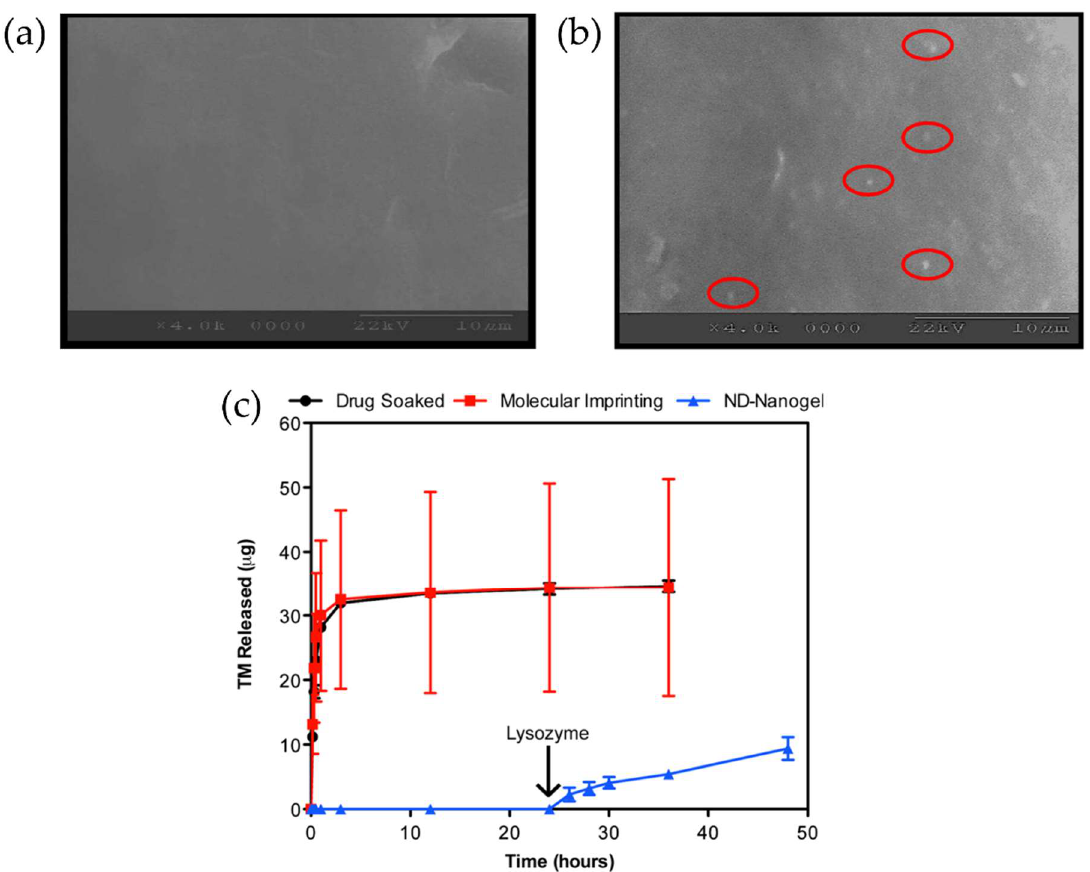
Figure 7 . SEM images of ( a ) the surface of pure poly-HEMA contact lens; ( b ) the surface of nanoparticle-laden poly-HEMA contact lens with visible nanoparticles (red circle). Reprinted with permission from [30]; ( c ) Timolol-eluting profiles from drug-soaked (black line), molecularly imprinted (red line) and nanodiamond nanogel-embedded contact lenses (blue line), showing lysozyme-triggered drug release. Reprinted with permission from